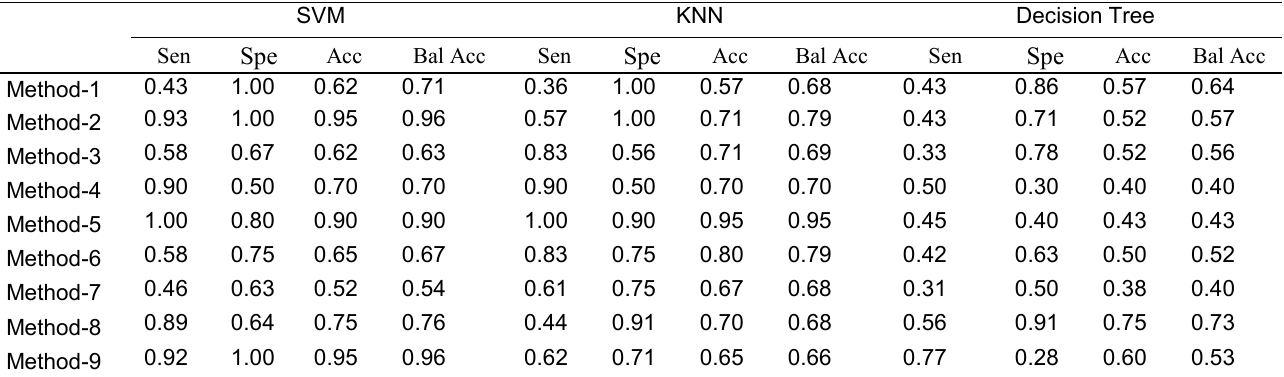
Table 8. Performance of classifiers for chest rotation.